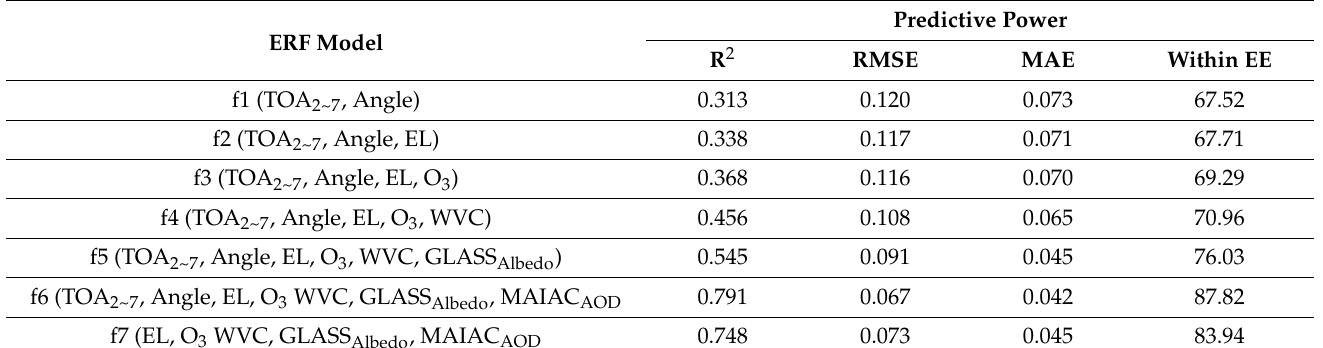
Table 5. Statistics concerning the estimation results of seven combinations of